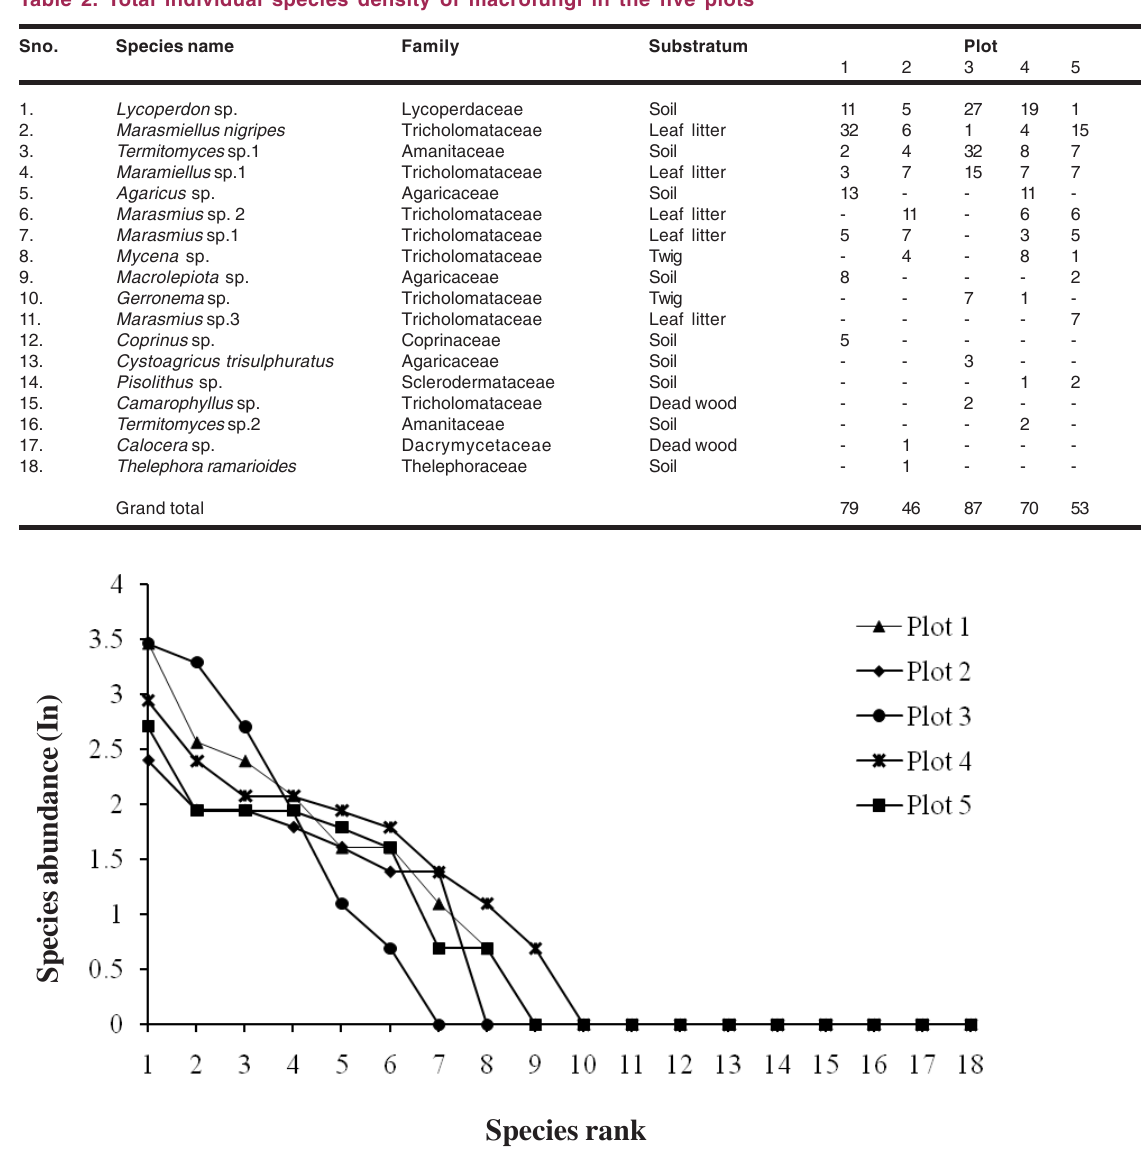
Figure 2. Species rank abundance of the five plots in the man-made Pitchandikulam Forest of Tamil Nadu, southern